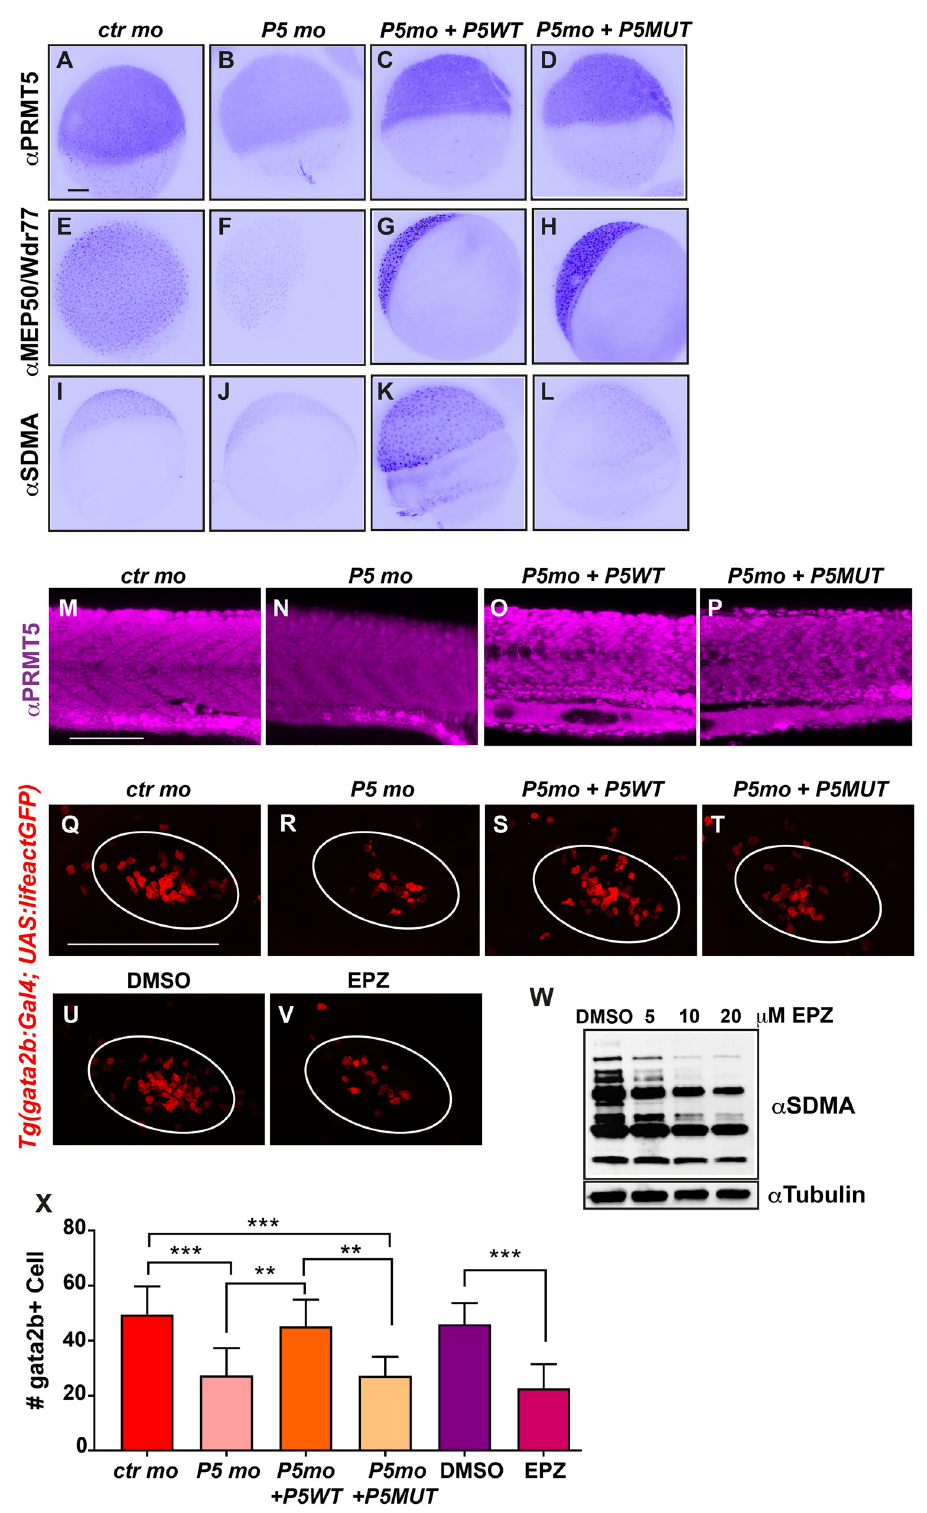
Fig 2. PRMT5 methyltransferase activity is required for HSPC maintenance. (A-D) PRMT5 immunostaining of 5 hpf embryos injected by control morpholino (A), or prmt5 morpholino only (B) or in combination with prmt5WT mRNA (C) or with the catalytic mutant form prmt5MUT mRNA (D). (E-H) Immunostaining of embryos as in